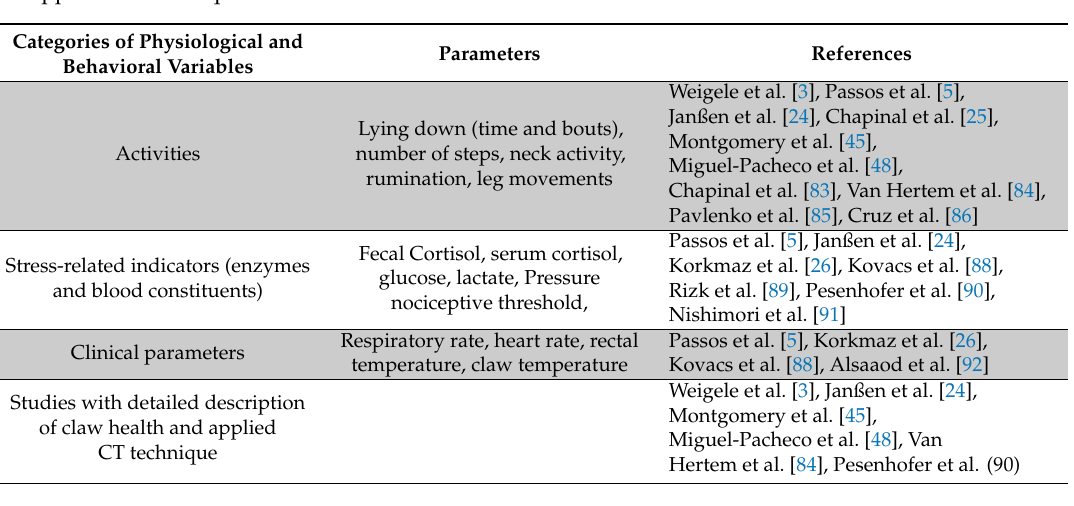
Table 2. Reviewed studies reporting associations between claw trimming and physiological and behavioral parameters in dairy cows and specific studies with detailed description of claw health and applied CT